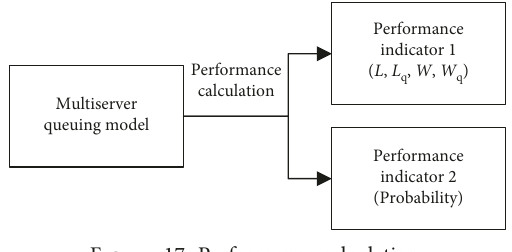
Figure 17: Performance